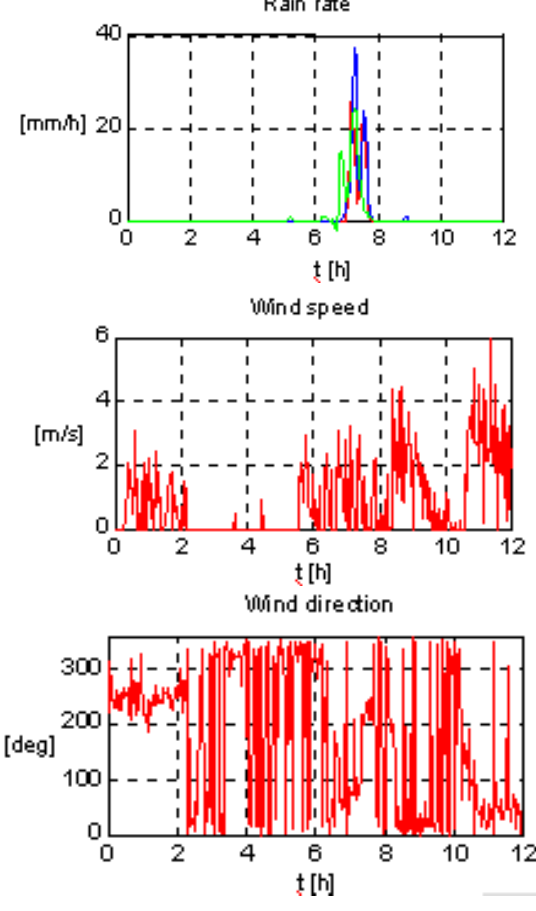
Figure 8. Simulation results (left) and radiometric measurements (right). Date: August 18, 1998, 0-12 h.